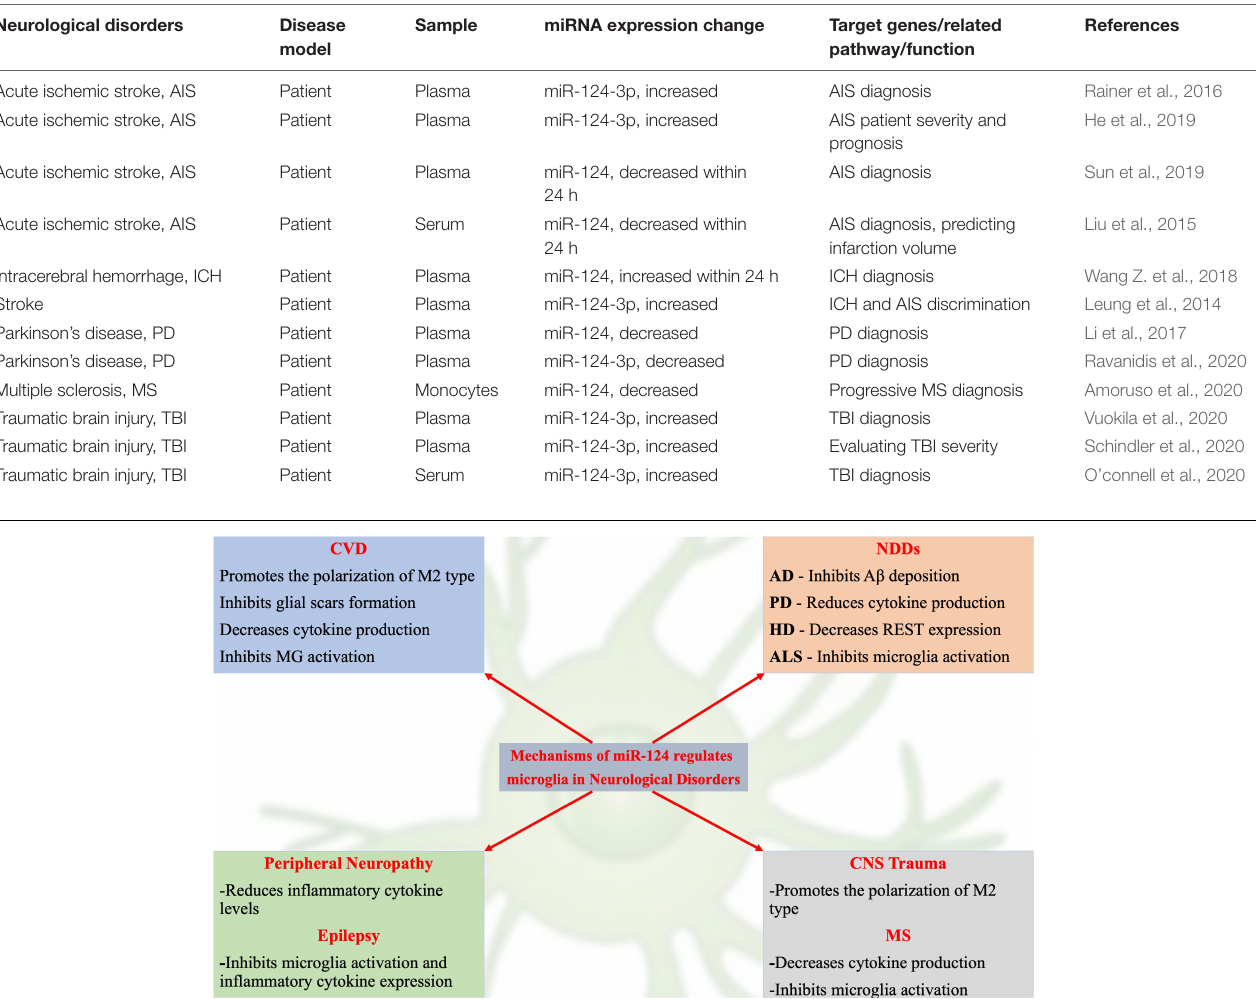
TABLE 1 | Circulating miR-124 expression as circulating biomarker in neurological disorders.